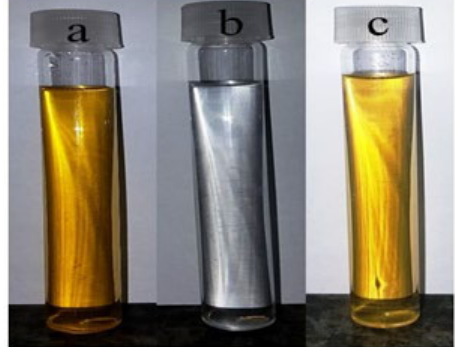
Fig. 6. The photographic representation of dye removal a) before, b) after using UV/TiO2, and c) after using UV–vis/BiVO4